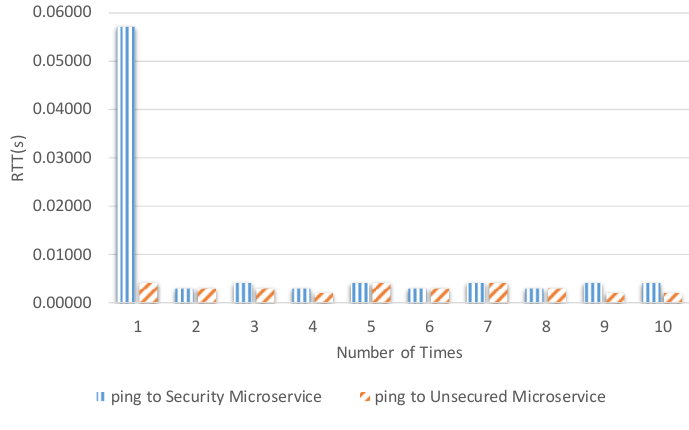
Figure 15. Round trip time for obtaining a token based on the getToken API.